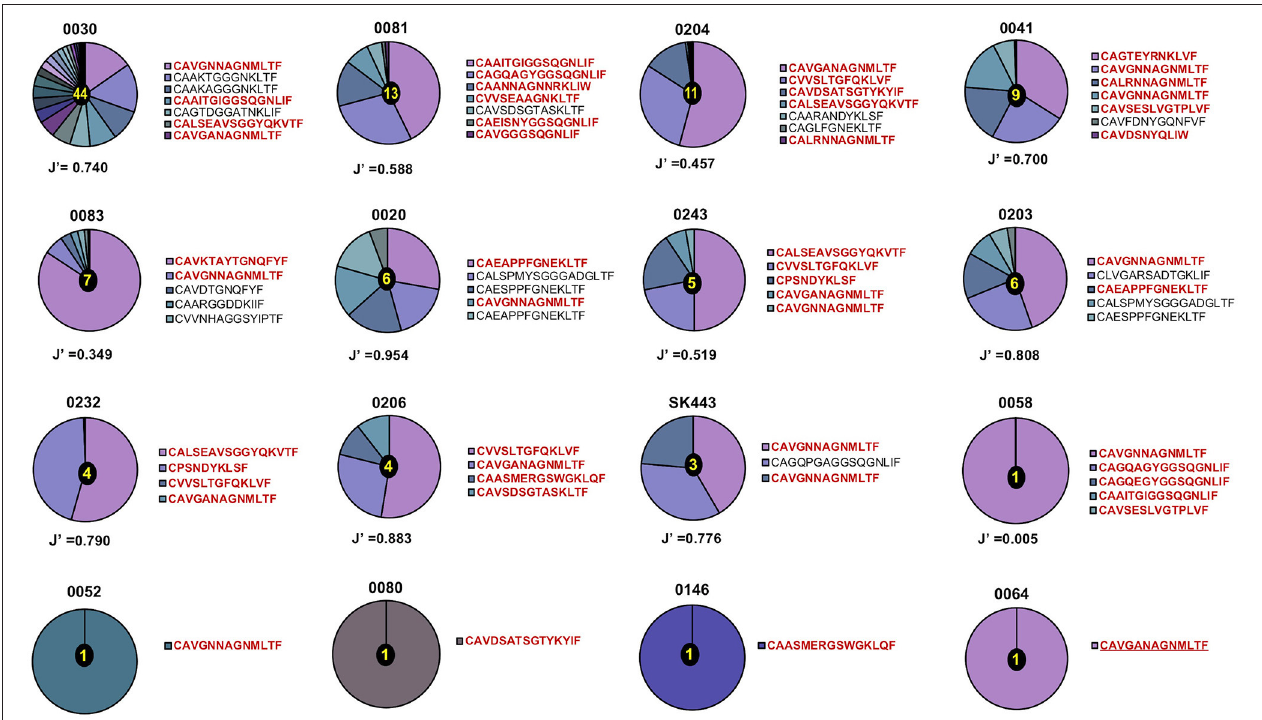
FIGURE 1 | Distribution of TCR- α chain clonotypes in HLA-B * 44:03/NW8-specific CD8 + T cells. The frequency of TCR- α chain amino acid sequences obtained from ( n = 16) CMV-infected individuals is shown as pie charts. Frequencies of individual clonotypes are calculated as a percentage of aligned sequencing reads. Amino acid sequences of CDR3 loops are shown on the right of each pie, with public CDR3 clonotypes in bold red. Patient IDs are shown above each pie chart. Shannon’s evenness index (J ′ ) is indicated under each pie chart. The number in the centre of each pie indicates the total number of clonotypes seen in the corresponding patient. Colours are assigned randomly and do not correspond to a fixed a